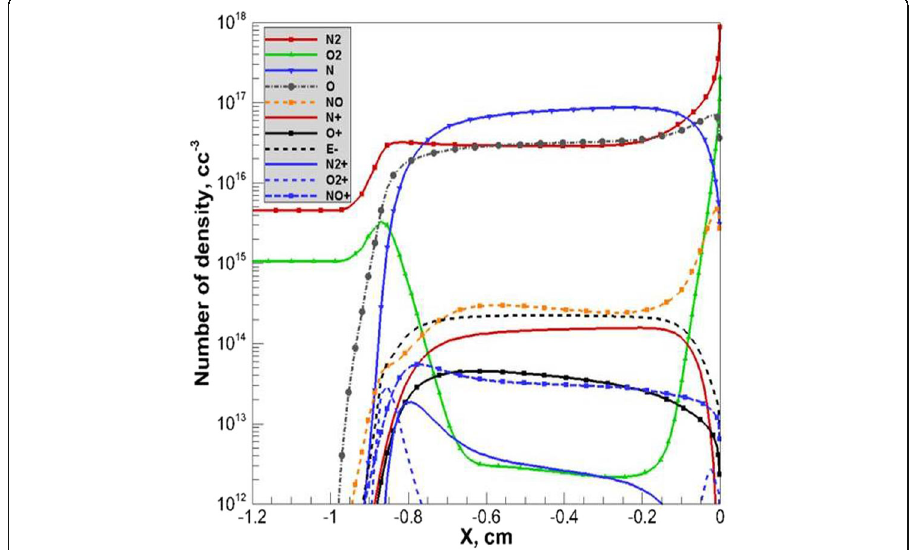
Fig. 6 Species concentration in shock layer of RAM-C-II